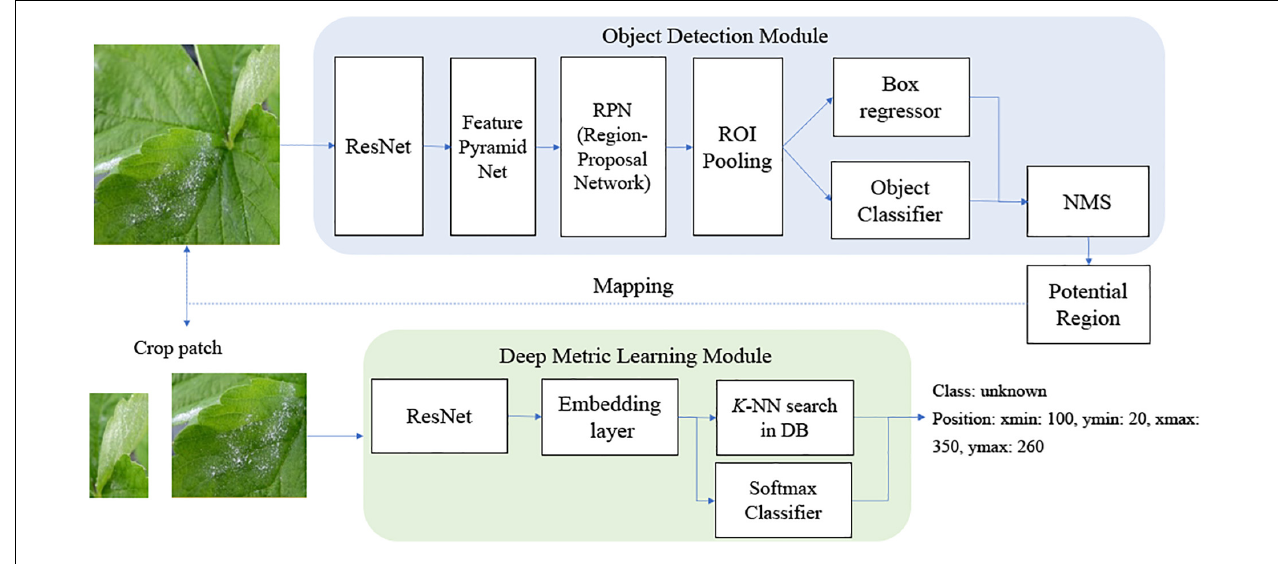
FIGURE 1 | Structure of overall scheme for inference.